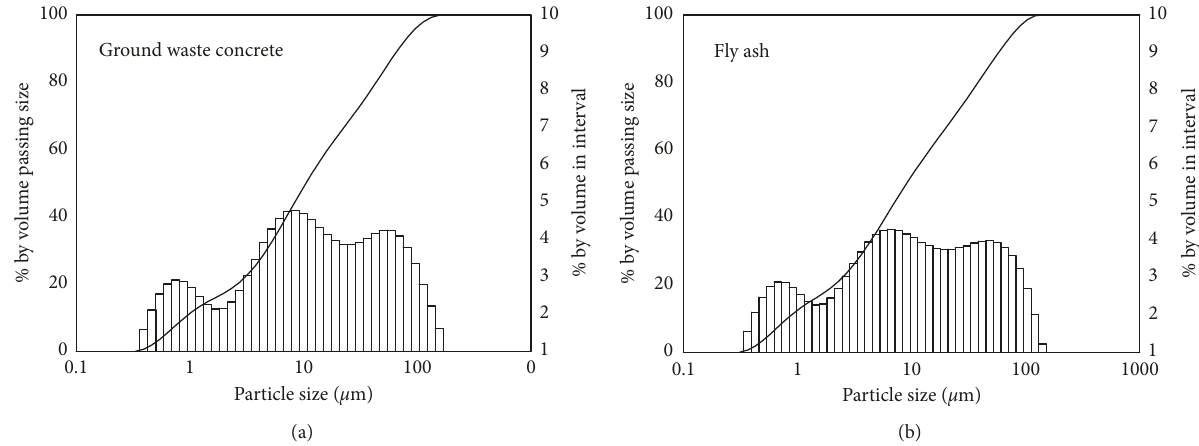
Figure 1: Particle size distribution of fly ash (a) and ground waste concrete (b).